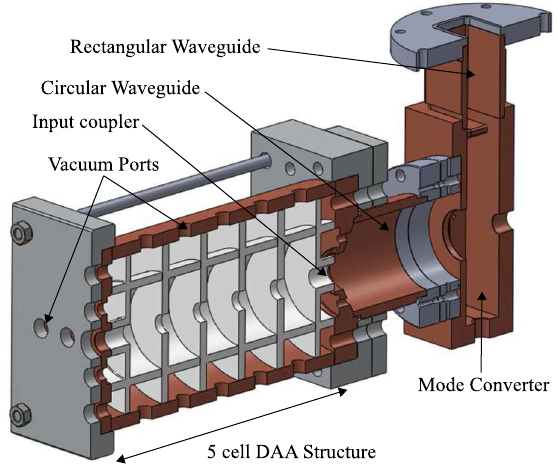
FIG. 10. Schematic half-cross section of the DAA structure assembly including the input coupler and the TE-TM mode converter.